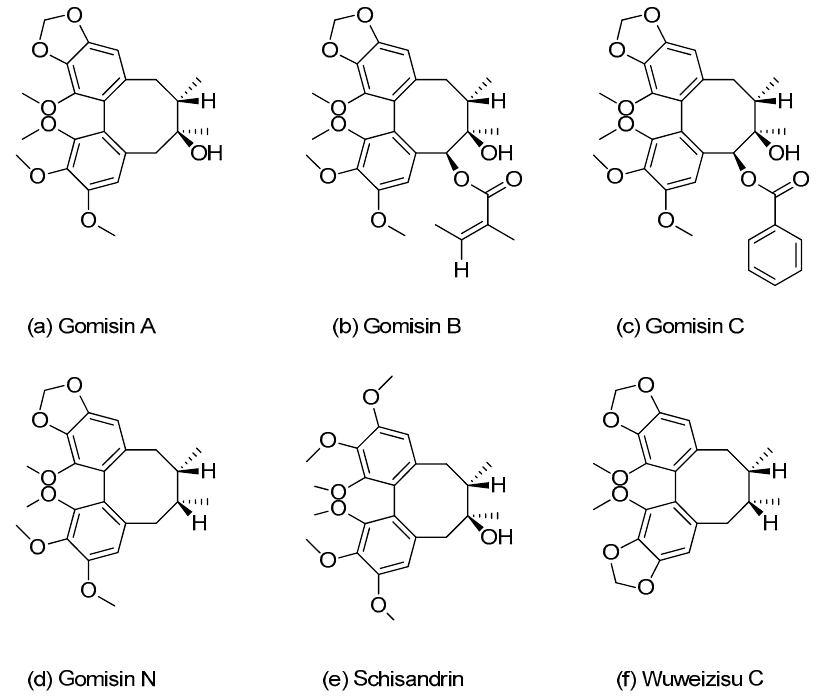
Figure 1. Chemical structures of the six lignans: ( a ) gomisin A, ( b ) gomisin B, ( c ) gomisin C, (d ) gomisin N, ( e ) schisandrin, and ( f ) wuweizisu C.